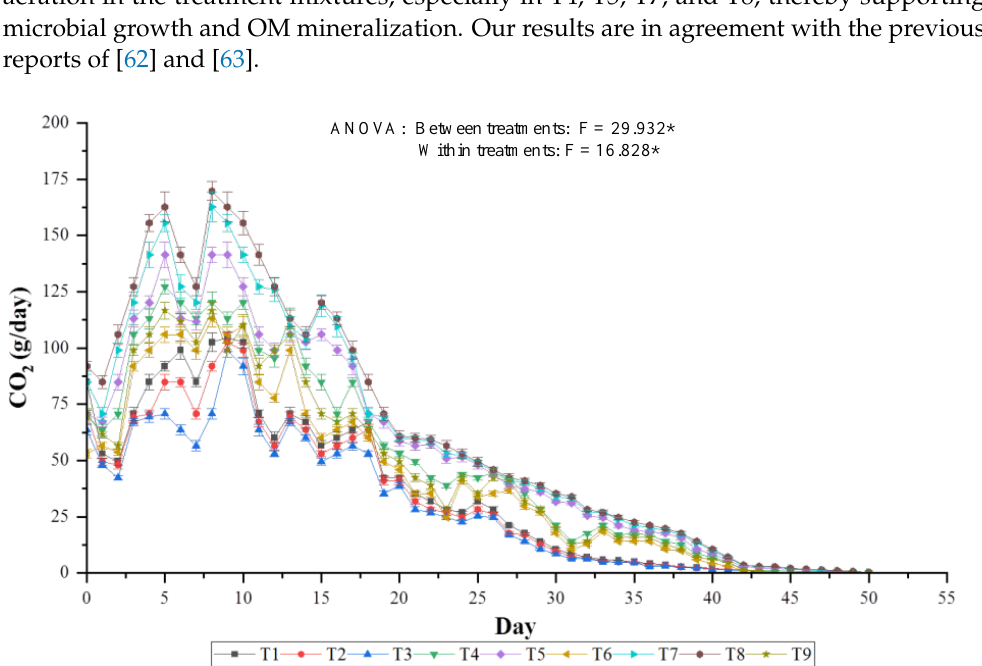
‘*’ indicates a significant difference at p < 0.05 by ANOVA.